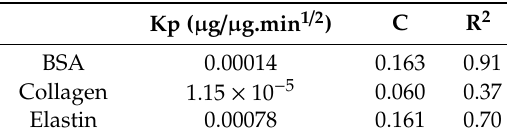
Table 4. Parameters calculated from intra-particle diffusion model. Note: Kp, intra-particle diffusion rate constant; C, the thickness of the boundary layer.